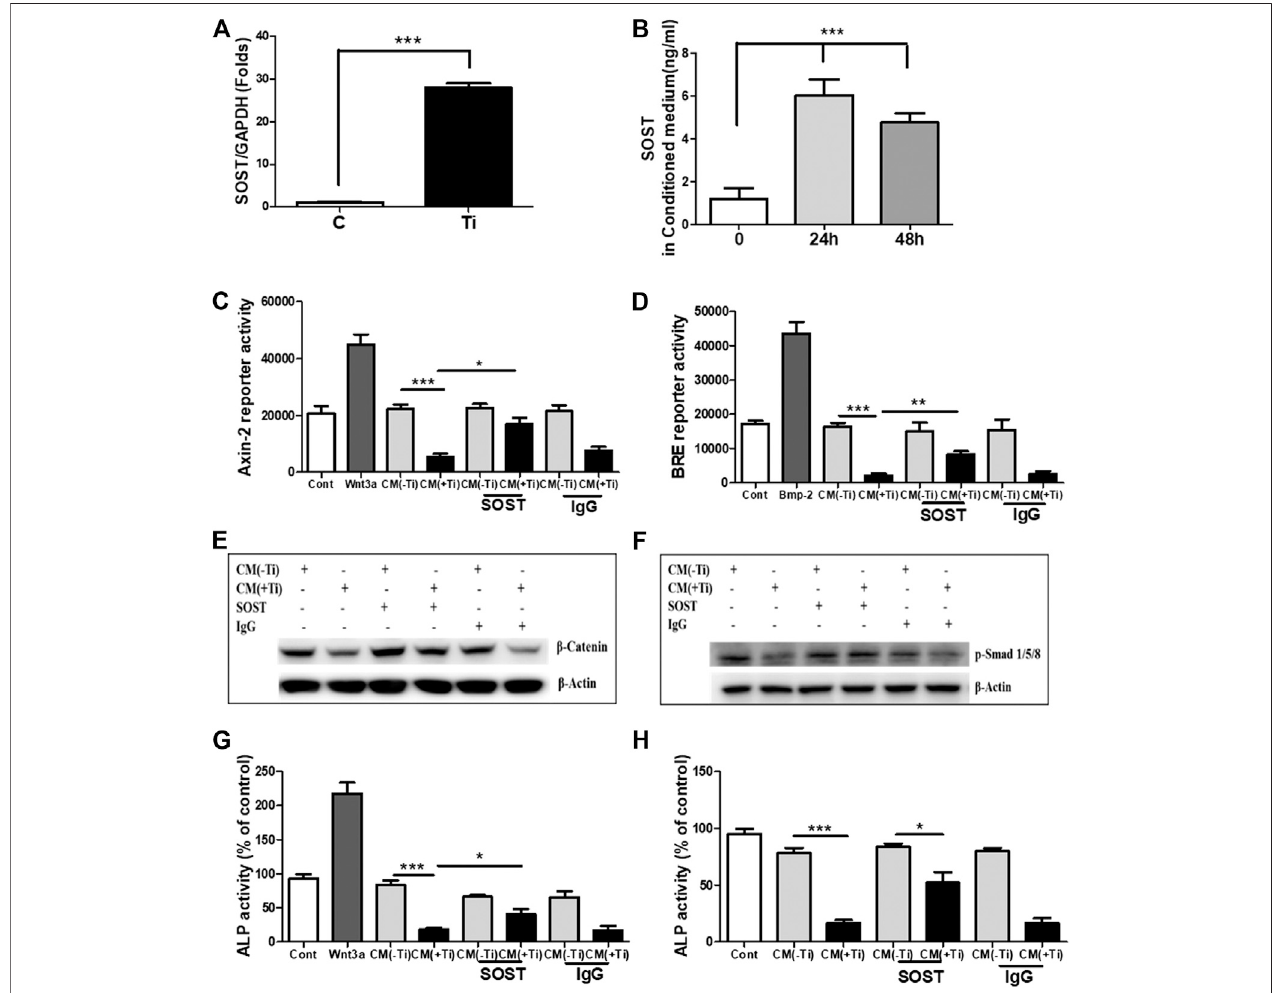
FIGURE7 | SOSTin theTi CMisresponsiblefor suppressed WNT and BMP signaling and ALPactivity inosteoprogenitors. (A) Treatment ofFLSs with Tiparticles inducedthemRNA expression ofSOST( ∼ 40folds)inFLSs. (B) ELISAshowed induced SOSTrelease intheCMofFLSs after 24 h ( ∼ 6 ng/mL)and 48 h( ∼ 5 ng/mL) ofTi particletreatment. (C) AntibodiesagainstSOSTwereincubatedintheTiCMfor2 hpriortotreatmentofSaOS-2cells.After24 hoftreatment,Axin-2reporteractivityand (D) BRE reporter activity were analyzed. (E) Protein expression of β -catenin was analyzed by SDS gel electrophoresis. (F) Stability of p -Smad 1/5/8 protein expression was analyzed by SDS gel electrophoresis. (G) Changes in ALP activity of SaOS-2 were analyzed after 48 h of treatment. (H) Antibodies against SOST were incubated in the Ti CM for 2 h prior to treatment of primary human osteoblast cells. After 48 h of treatment, changes in ALP activity were analyzed. Data are shown as mean ± SD. Similar results were obtained in three independent experiments. * p < 0.05, ** p < 0.01, and *** p < 0.001 vs.